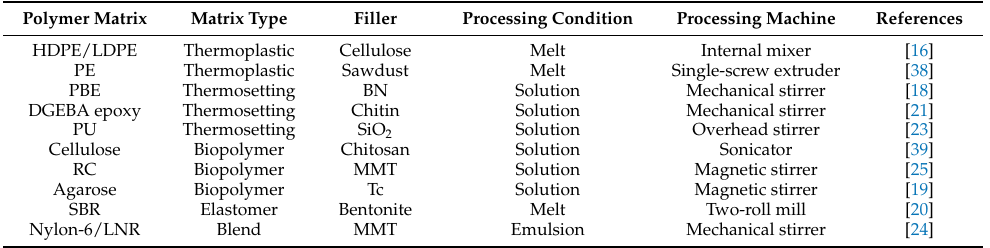
Table 4. Examples of polymer matrices, matrix types, fillers, processing conditions, and process- ing